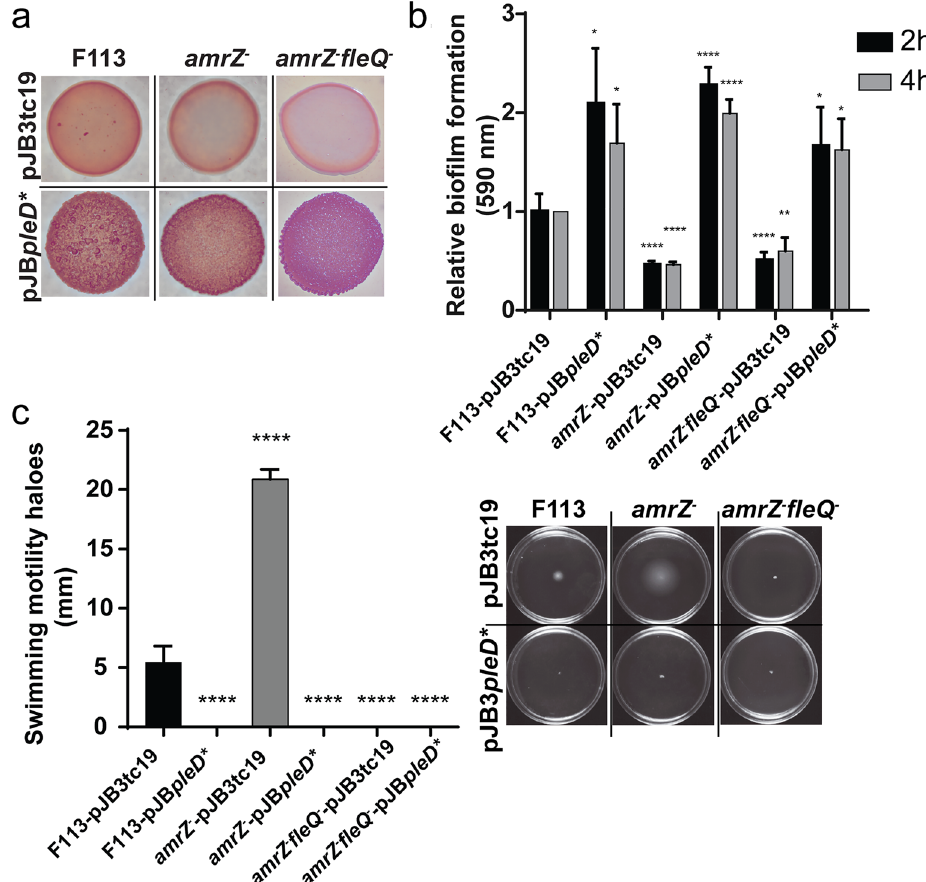
Figure 4. c-di-GMP restores the biofilm and motility phenotypes in amrZ - and amrZ - fleQ - . ( a ) Morphology and Congo Red (CR)-binding pattern of Pseudomonas ogarae F113 and derivatives colonies carrying either the empty plasmid pJB3Tc19 or pJBpleD* grown for 48 h in Yeast-Mannitol-Broth (YMB) medium containing CR and Tc (zoom 1.25x). ( b ) Relative crystal violet-based biofilm formation assay of P. ogarae F113 and derivatives carrying pJB3Tc19 or pJB pleD * after 2 h and 4 h growth in microtiter plates with LB medium. The average and SD of four biological replicates with 16 technical replicates are represented; data was relativized to F113pJBTc19. ( c ) Swimming motility assay of P. ogarae F113 and derivatives carrying pJB3Tc19 or pJB pleD * at 24 h in SA medium containing Tc. Average and SD of three biological replicates with three technical replicates are shown. Images show swimming haloes formed after 24 h. Asterisks denote statistical significance of the data according to t-tests with Bonferroni-Dunn correction: * p value < 0.05; ** p value < 0.01; **** p value <